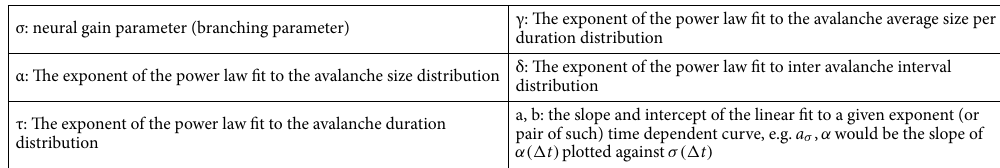
Table 1. Notation used to denote MsCr measures. See Fig. 2 for an illustration of computing MsCr features as well as for a detailed description 20 .